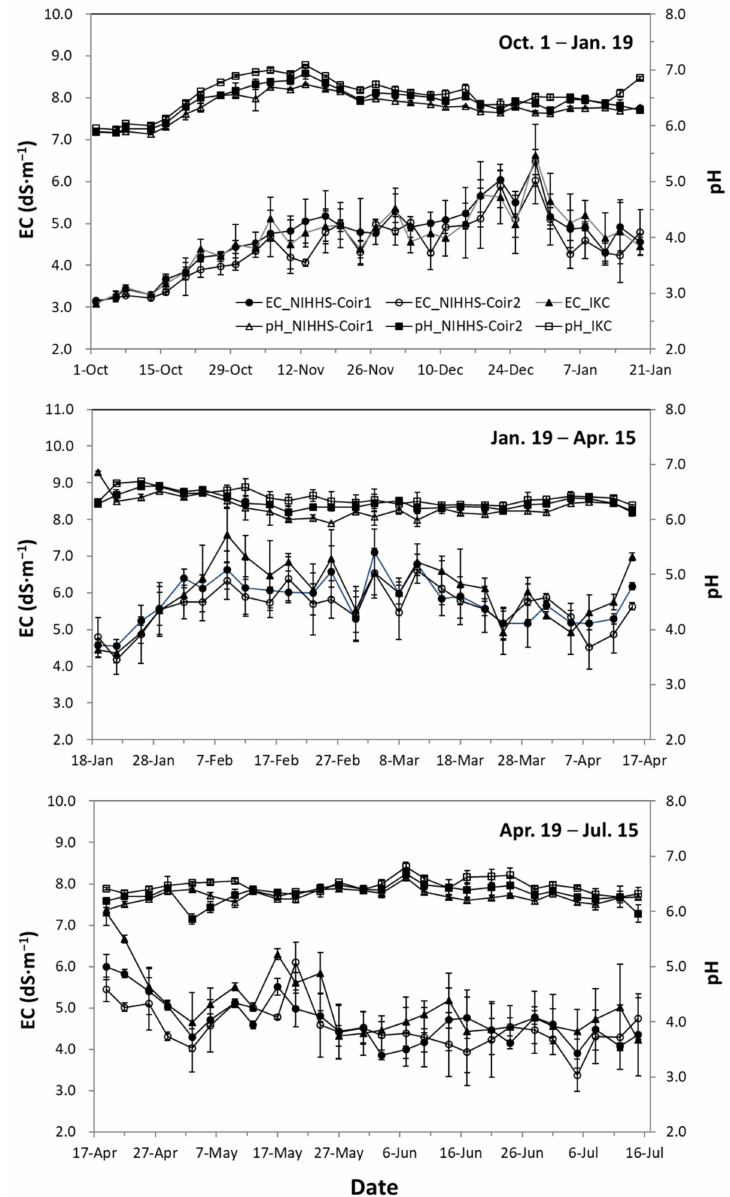
Figure 5. Changes in EC and pH in the RZ of each nutrient solution composition (NIHHS-Coir1, NIHHS-Coir2, and IKC) in the closed hydroponic system with a coir substrate. Vertical bars indicate standard errors of the means ( n =